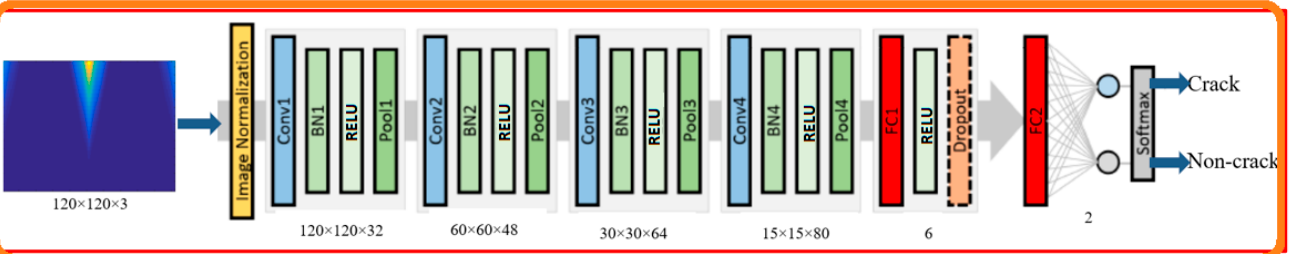
Figure 11. CNN architecture (four layers) for crack and non-crack concrete classification.